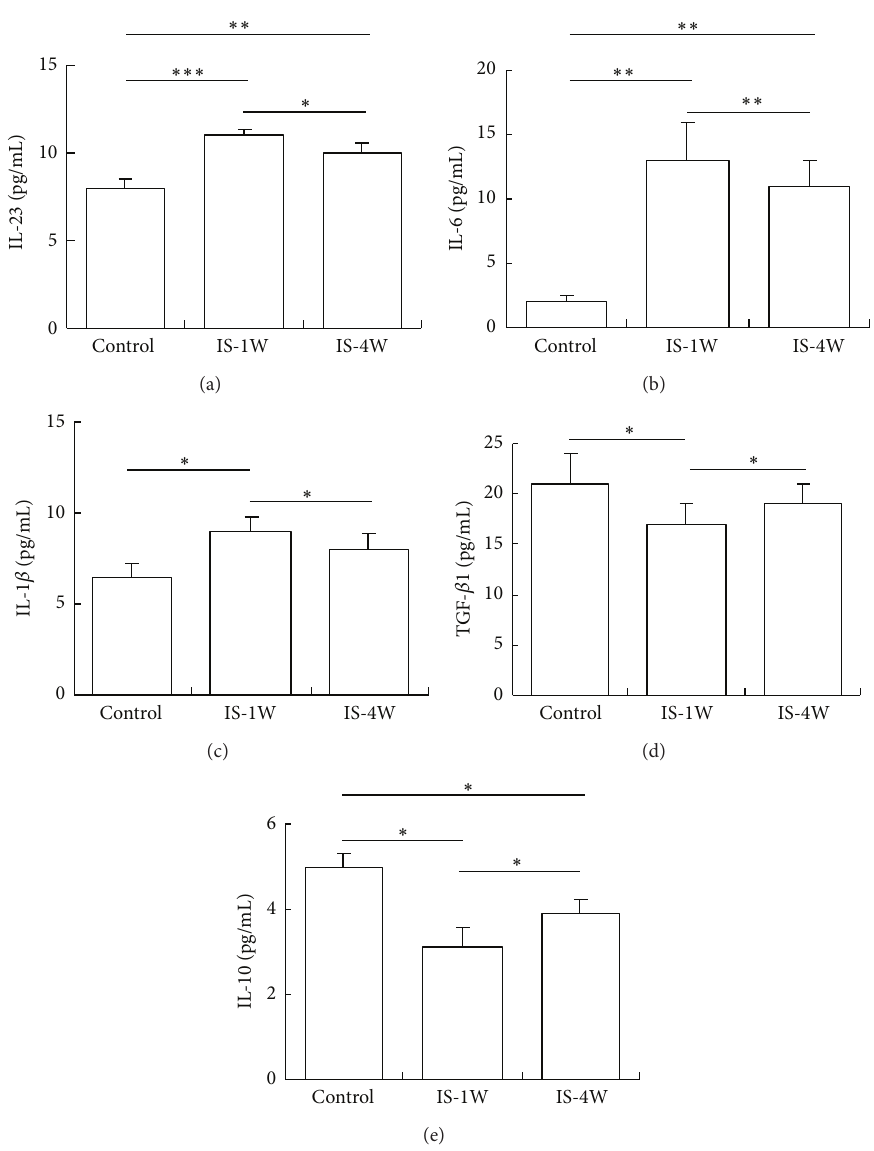
Figure 4: Plasma cytokine levels in patients. The plasma IL-23 (a), IL-6 (b), IL-1 𝛽 (c), TGF- 𝛽 (d), and IL-10 (e) levels in 30 control subjects and 50 IS patients at 7 and 28 days after stroke were analyzed using ELISA. ∗ 𝑃 < 0.05 , ∗∗ 𝑃 < 0.01 , and ∗∗∗ 𝑃 < 0.001 . IS-1W = 1 week after IS; IS-4W = 4 weeks after